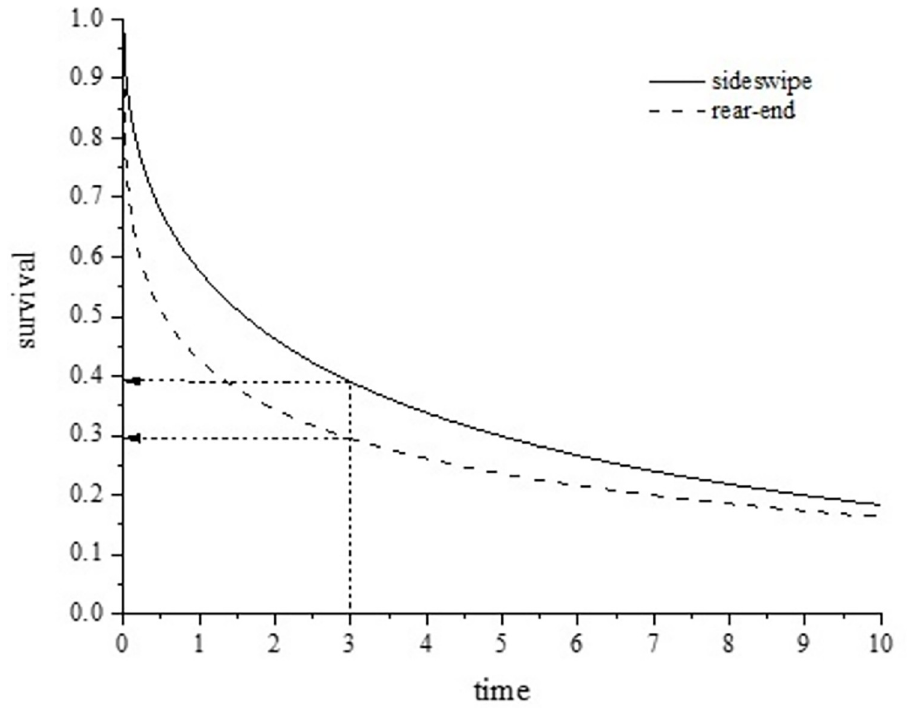
Fig 3. The figure of parametric survival analysis